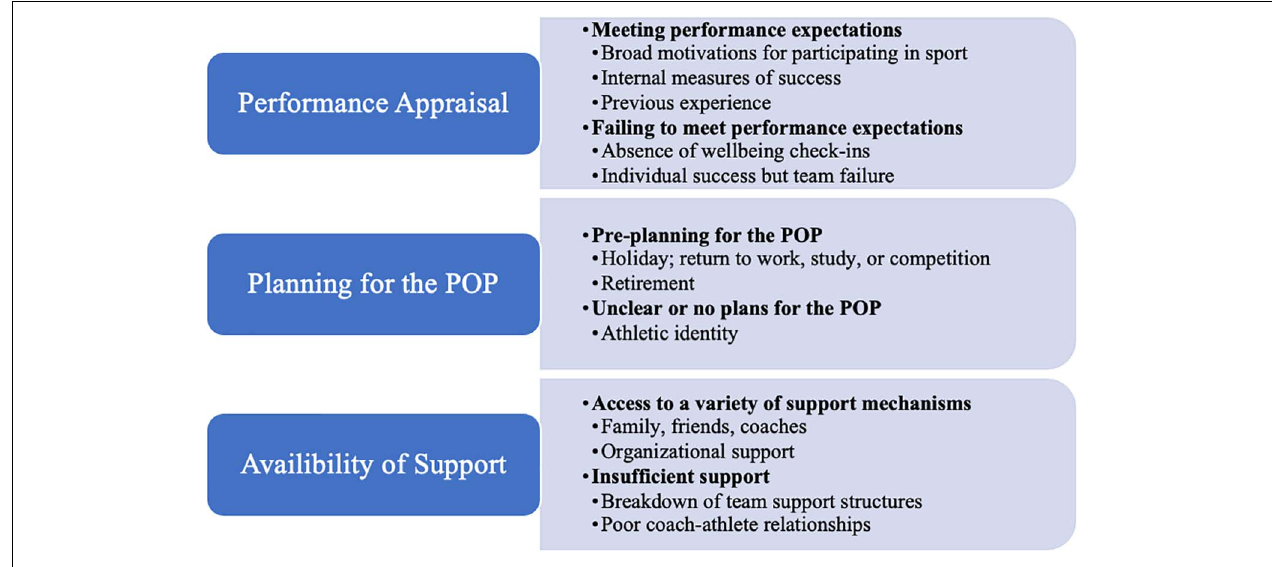
FIGURE 1 | Visual representation of